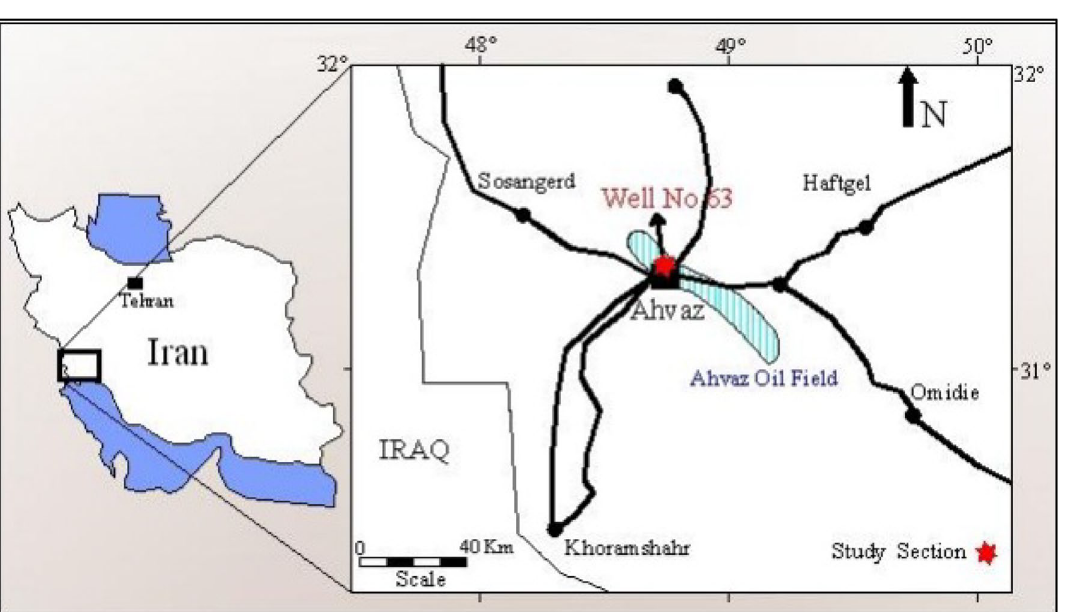
Fig. 2 Location of Ahwaz oil field in Southwest of Iran (Asghari and Adabi 2014) Ahwaz oil field contains different lithologies which one